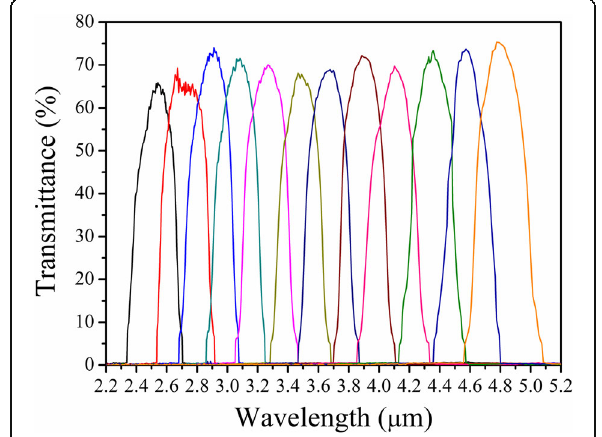
Fig. 8 Measured spectral response of LVOF